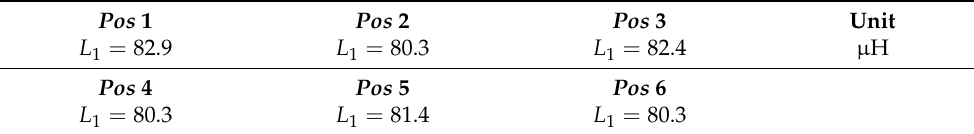
Table 5. Estimation results of L 1 in all six Pos for N 1 = 10.